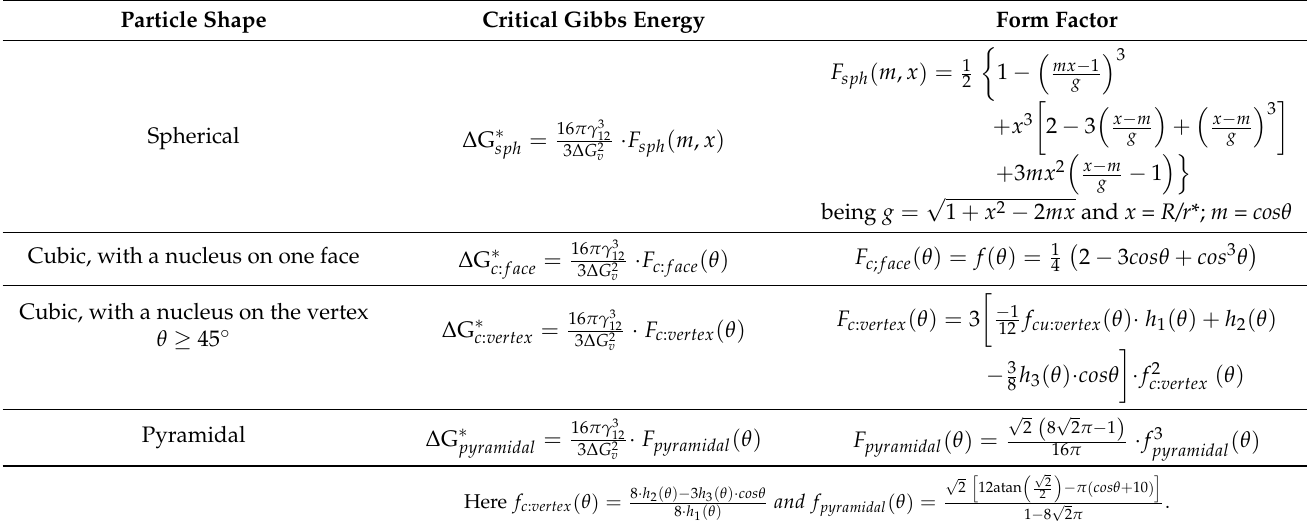
Table 3. Calculated critical Gibbs energy and form factor in the function of the particle shape.